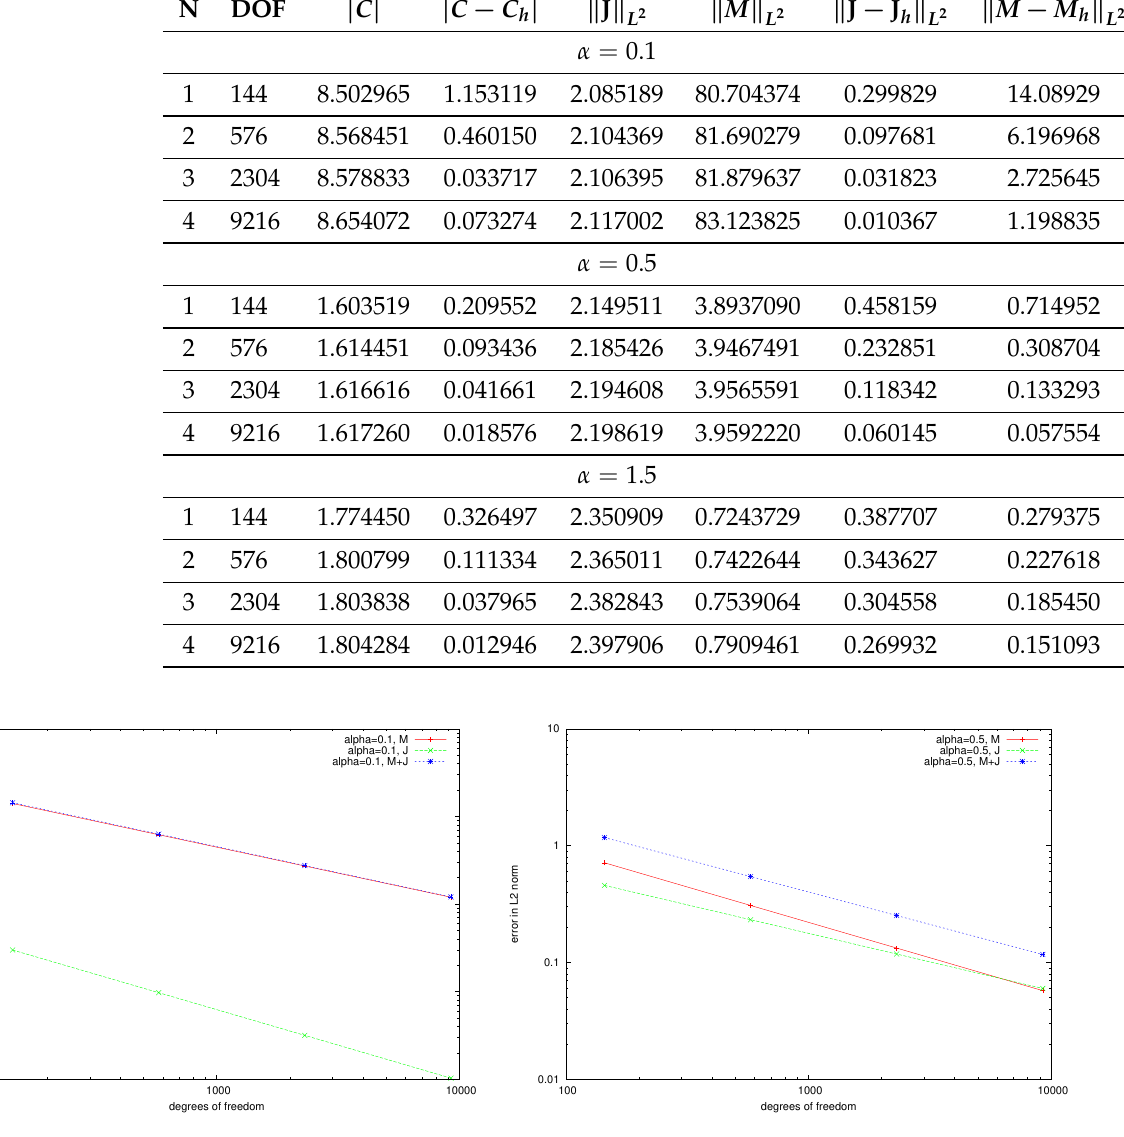
Figure 1. Errors in the L2-norm for α =